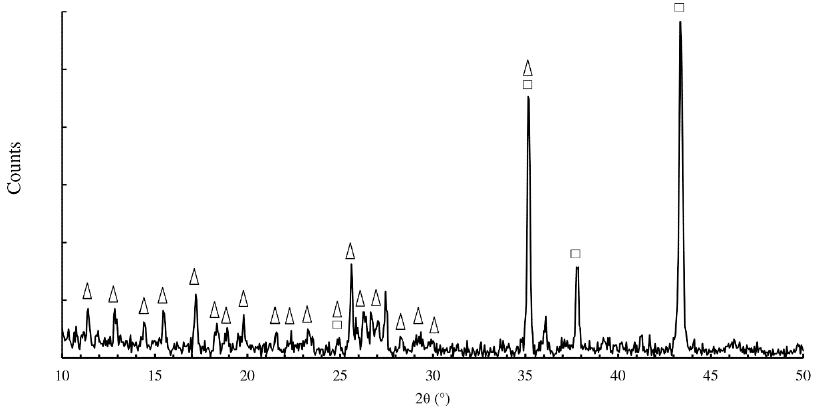
Figure 5. XRD pattern of the synthesized DD3R zeolite membrane.